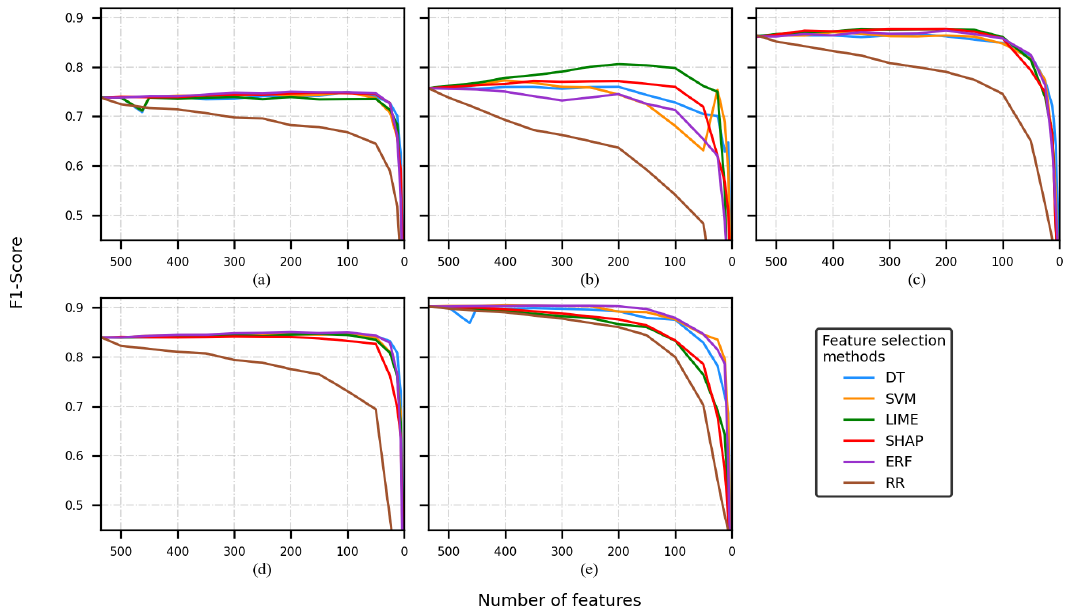
Figure 4. F1-score of the model is obtained by using a different number of features, using the CHB-MIT dataset and FS2. Classification model used: ( a ) decision tree, ( b ) support vector machine, ( c ) artificial neural network, ( d ) random forest, and ( e ) K-nearest neighbor.